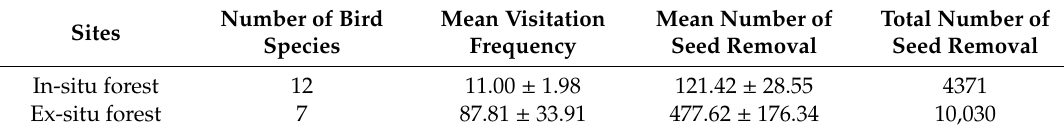
Table 1. Seed removal by frugivorous birds in three years (2016–2018) across in-situ and ex-situ sites, southeast China.